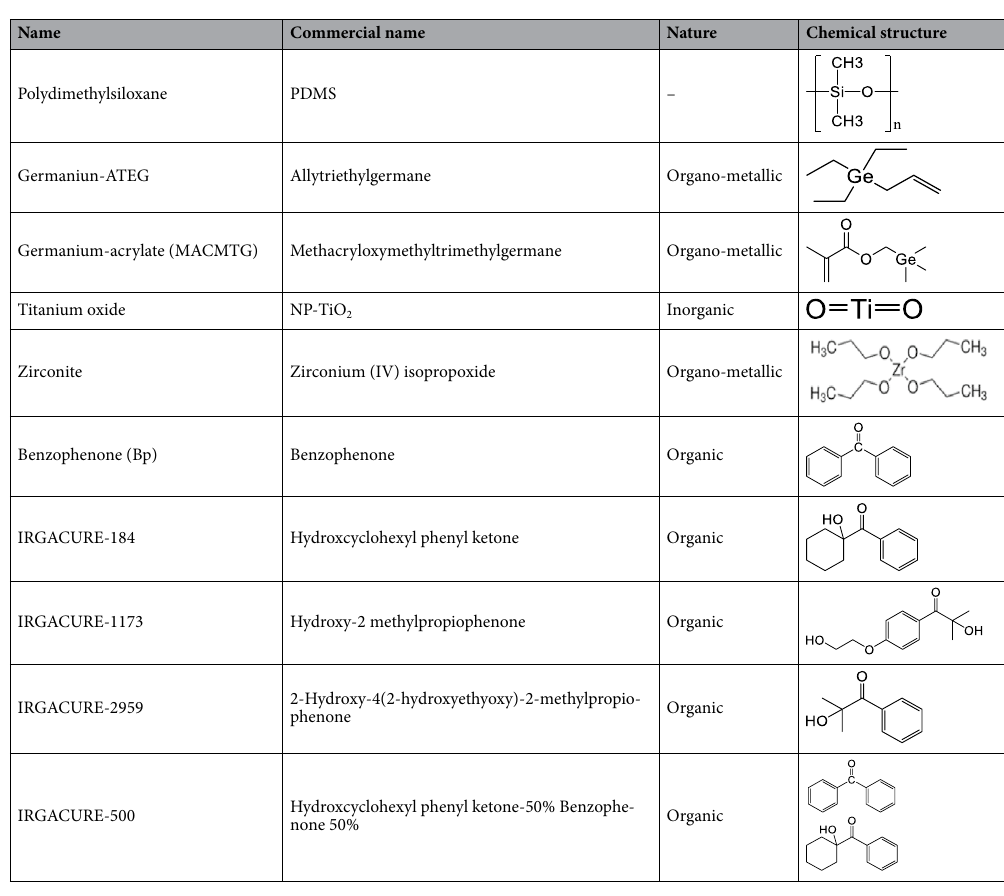
Table 1. Potential photosensitizing materials under investigation.